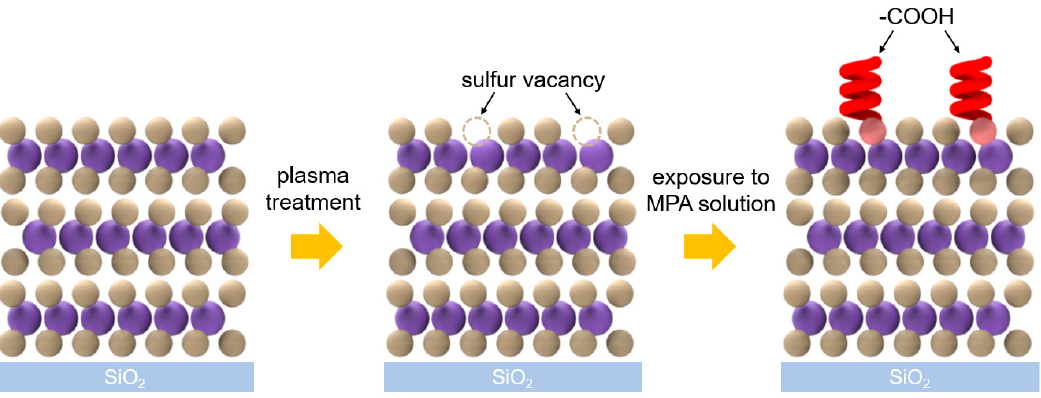
Figure 2. Schematic representation of the efficient and stable functionalization of an MoS 2 film.